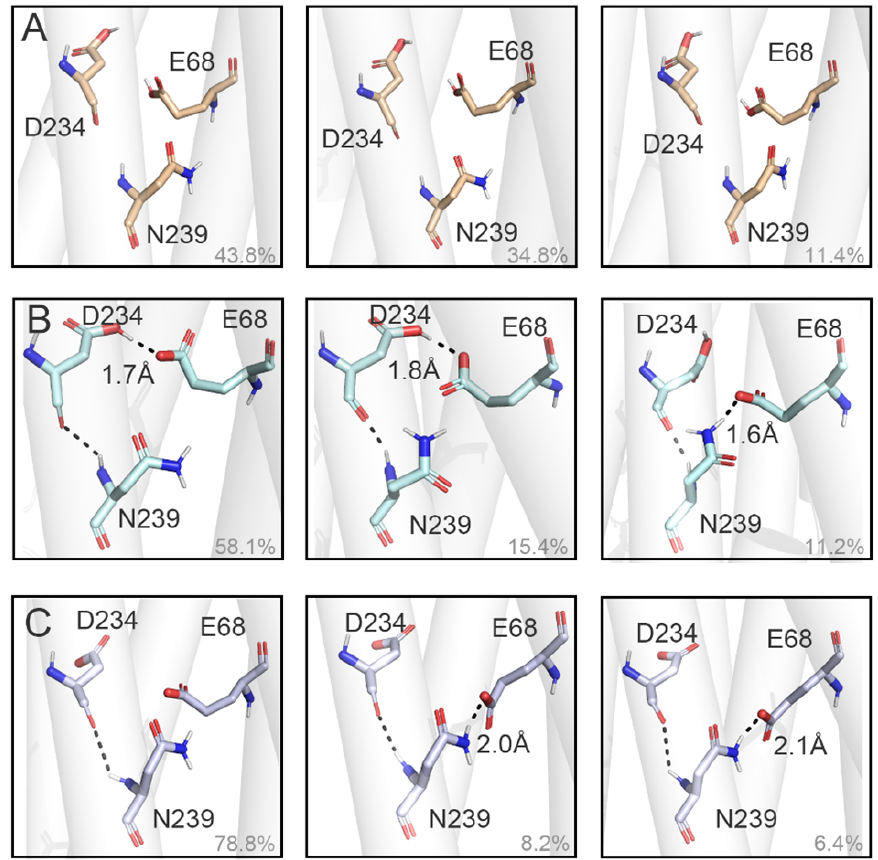
Figure 7. Clustering analysis for ( A ) E68p-D234p, ( B ) E68dp-D234p, and ( C ) E68dp-D234dp of GtACR1. The first, second, and third columns are the representative conformations of the top three clusters in each state. The cluster percentage is displayed in each